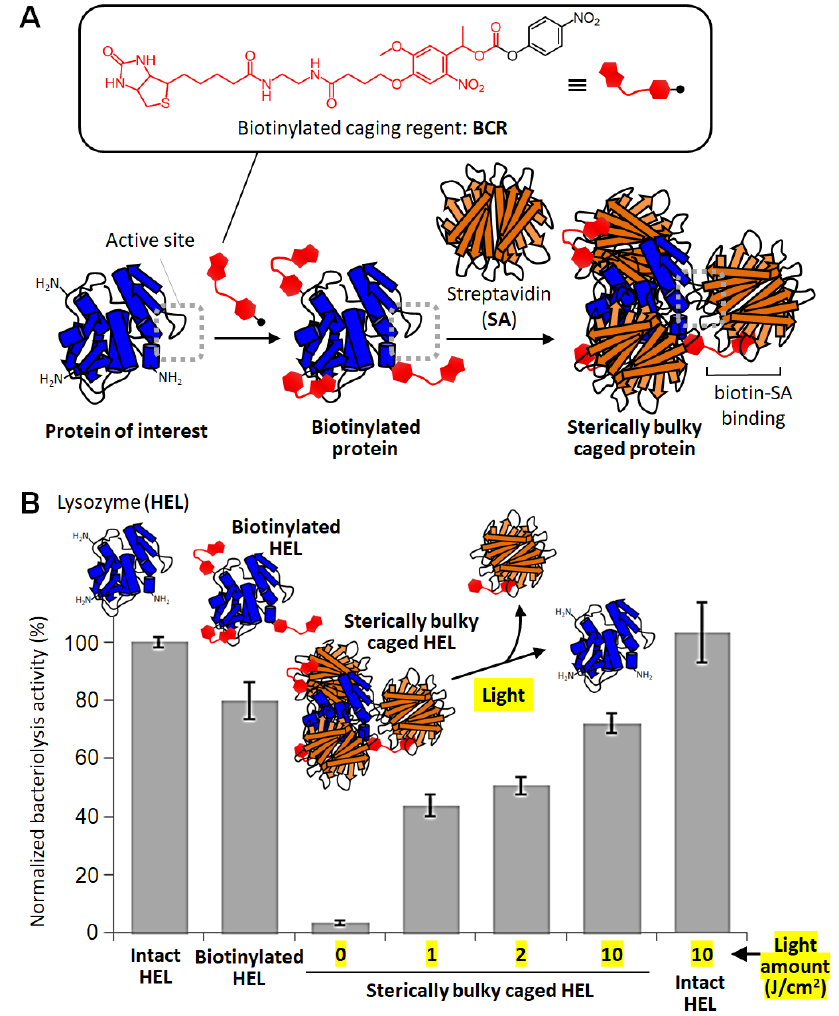
Figure 3. Sterically bulky caging of proteins. ( A ) Schematic illustration of the sterically bulky caging method and the chemical structure of biotinylated caging reagent (BCR). ( B ) Bacteriolytic activity of caged lysozyme before and after caging and light exposure [66].